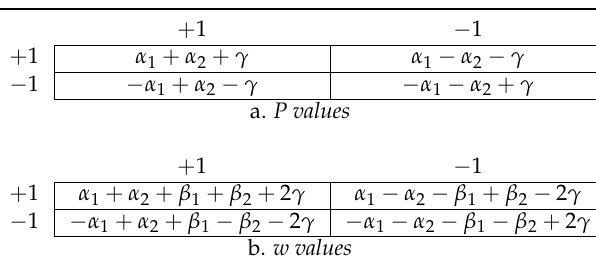
Table 11. A potential game’s P and w